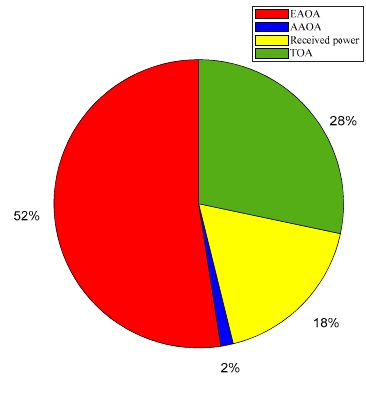
Figure 9. Features importance.